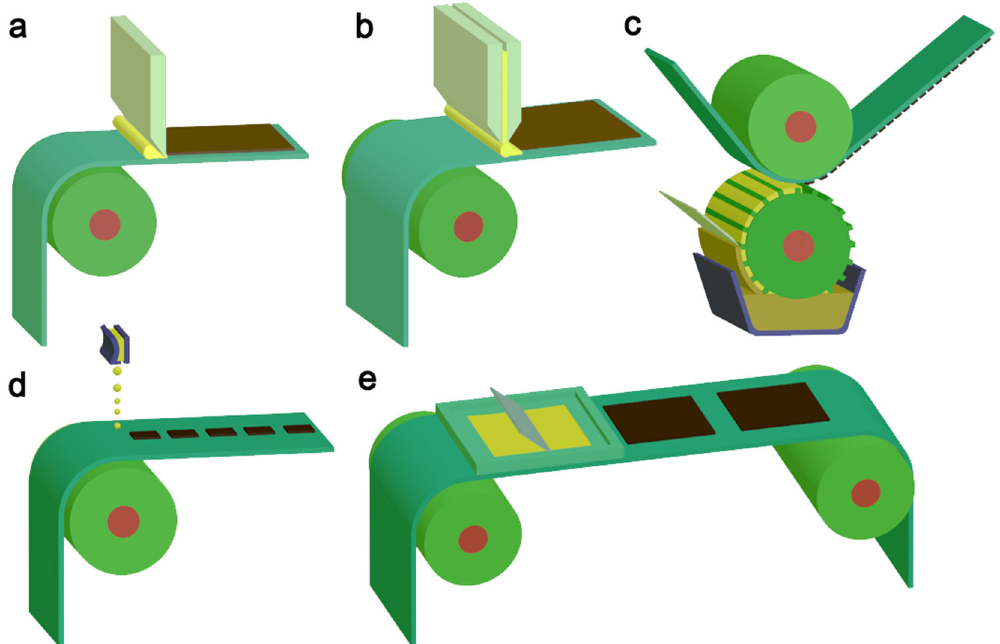
Fig. 6 Common scalable solution deposition methods for large-area fl exible OSCs that are compatible with roll-to-roll manufacturing. a Blade coating. b Slot die coating. c Gravure printing. d Inkjet printing. e Screen